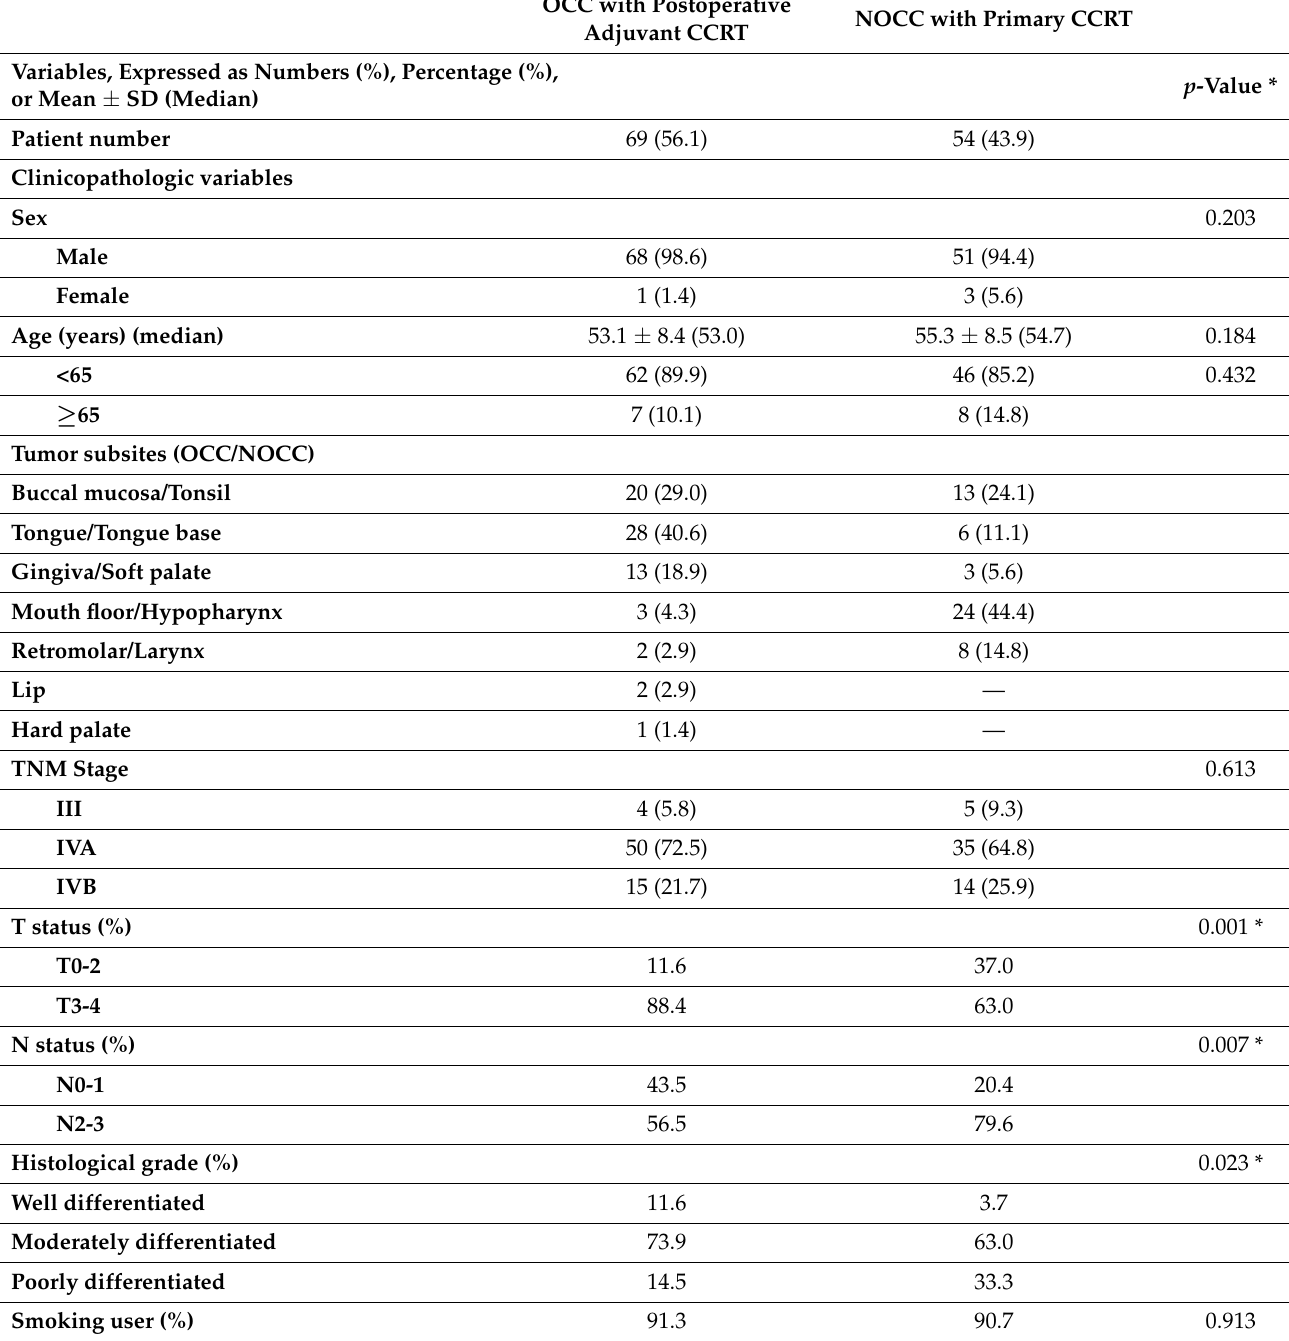
Table 1. Baseline and treatment characteristics of 69 patients with OCC treated with postoperative adjuvant CCRT and 54 patients with NOCC treated with primary CCRT. OCC with Postoperative NOCC with Primary Adjuvant CCRT